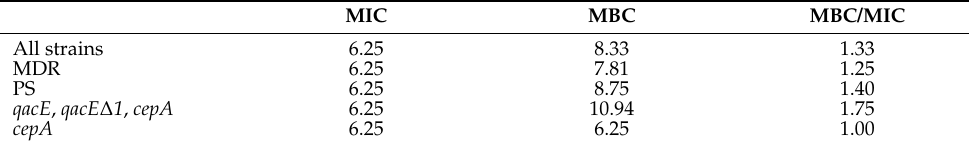
Table 4. Average MICs and MBCs of A. baumannii strains following isopropanol exposure. MIC MBC All